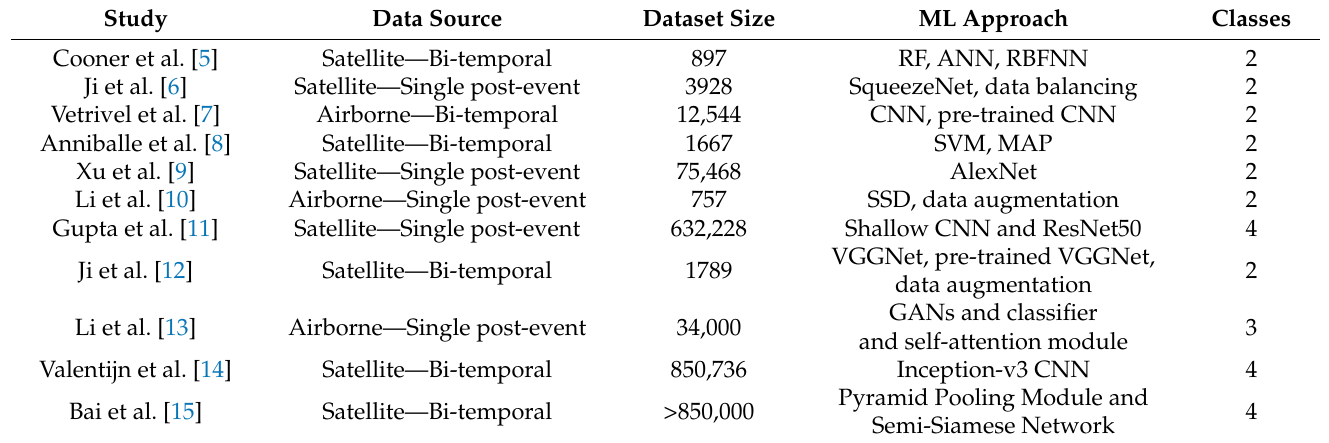
Table 1. Data parameters that affect the architecture design. Dataset size refers to building